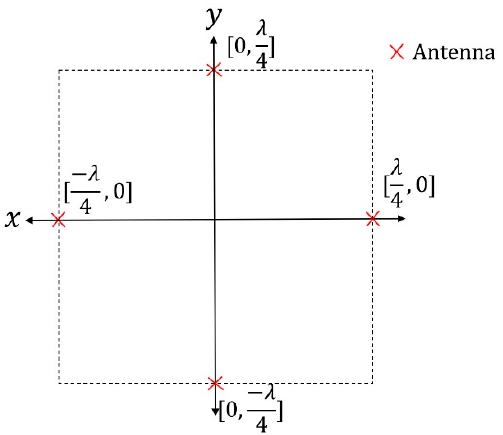
Figure 1. Two by two reconfigurable antenna array in a wavelength-normalized XY -plane.